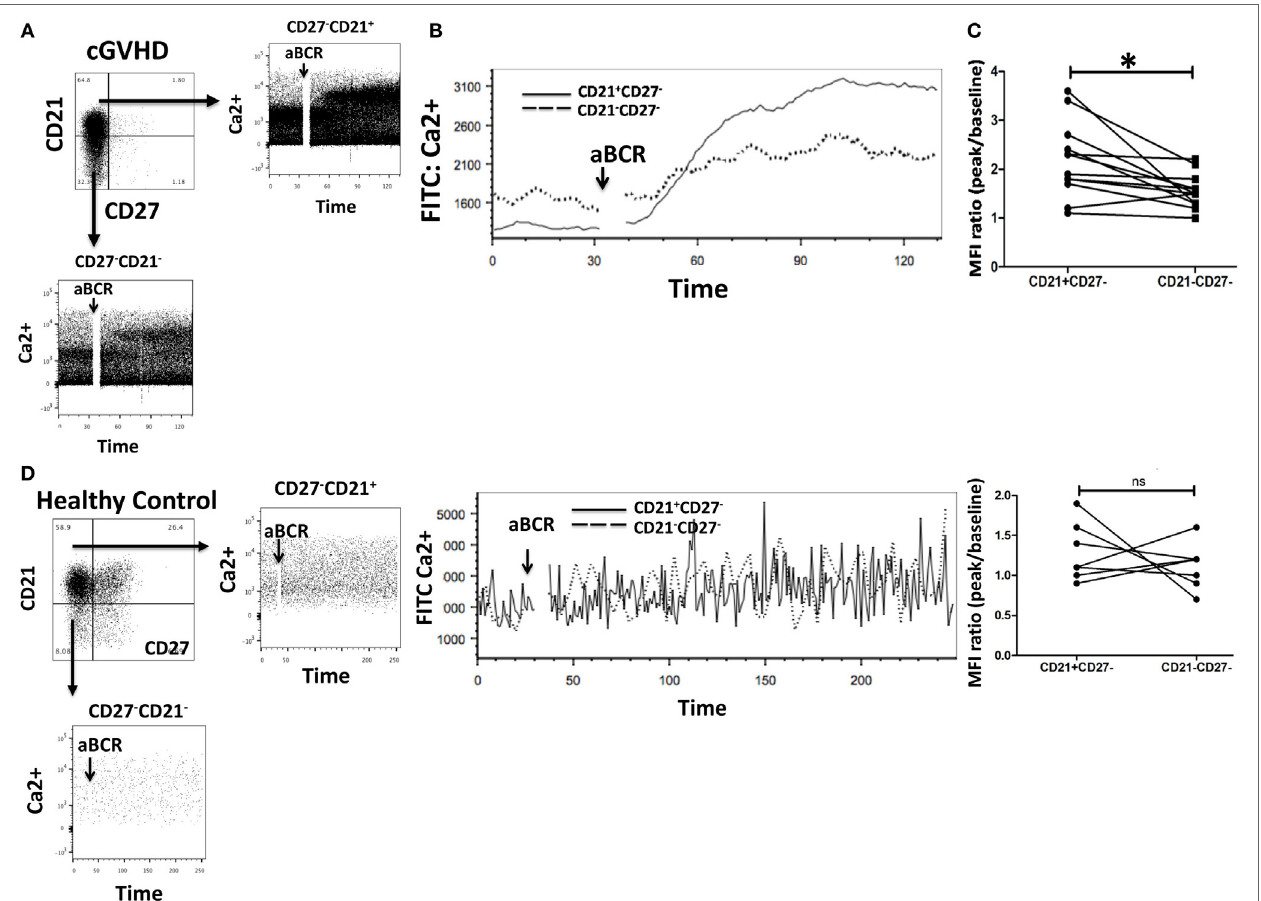
FigUre 5 | Exhausted B cells (CD21 − CD27 − ) fail to mobilize calcium (Ca2 + ) in response to B cell receptor (BCR) triggering. (a,B) Peripheral blood mononuclear cells from chronic graft-versus-host disease (cGVHD) patients were loaded with the calcium dye Fluo-4AM and stained with monoclonal antibodies against CD19, CD21, and CD27 ( n = 10). Ca2 + mobilization was assessed by flow cytometry after gating on CD21 − CD27 − and CD21 + CD27 − B cell subsets. CD21 − CD27 − B cells had an attenuated Ca2 + response compared to CD21 + CD27 − B cells. (c) Median fluorescence intensity (MFI) of Fluo-4AM was significantly lower in CD21 − CD27 − B cells ( n = 10); p = 0.005. (D) CD21 − B cells from healthy donors did not have reduced Ca2 + mobilization in response to BCR stimulation when compared with CD21 + B cells ( n = 8; p =